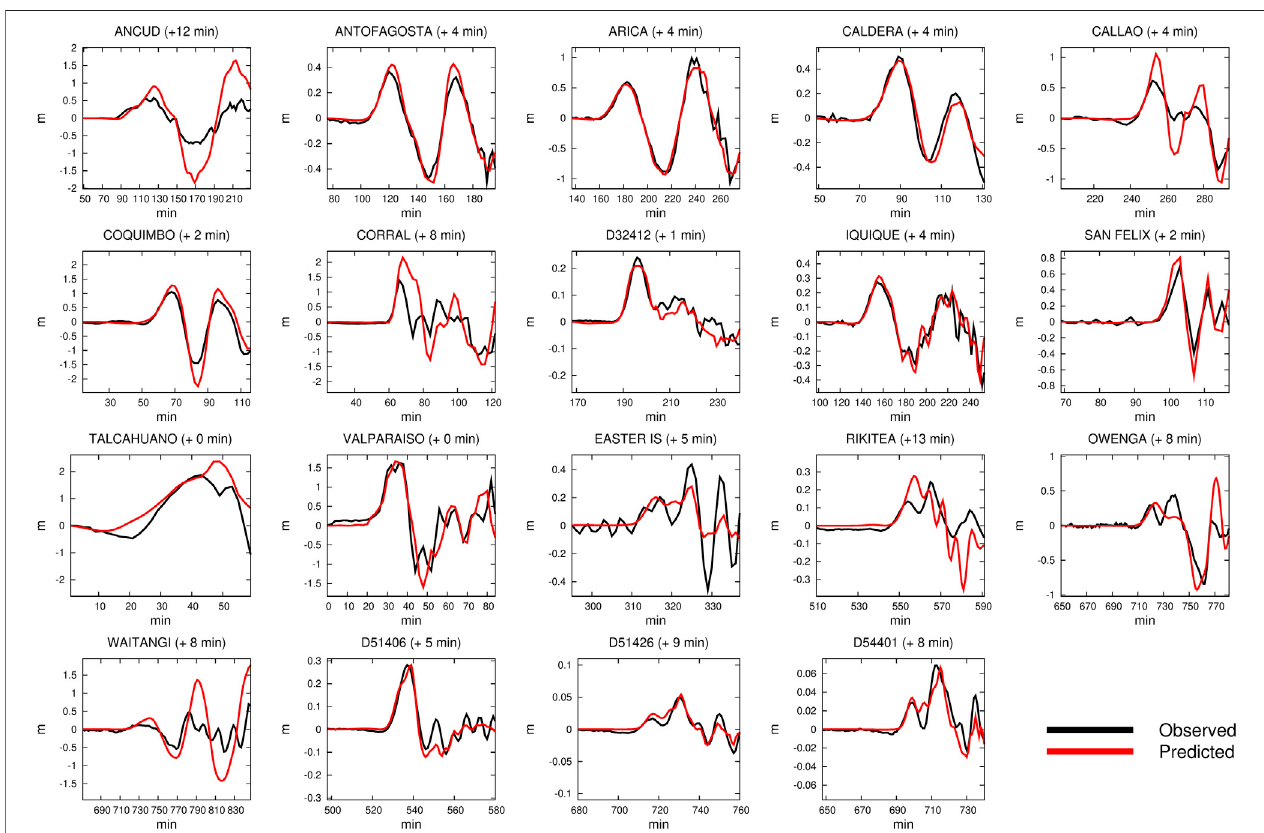
FIGURE 7 | Comparison between observed (in black) and predicted (in red) tsunami waveforms for the slip distribution obtained by jointly inverting geodetic and tsunami data using OTA ( Figure 6 ); the time mismatch estimated by the OTA is indicated within brackets.